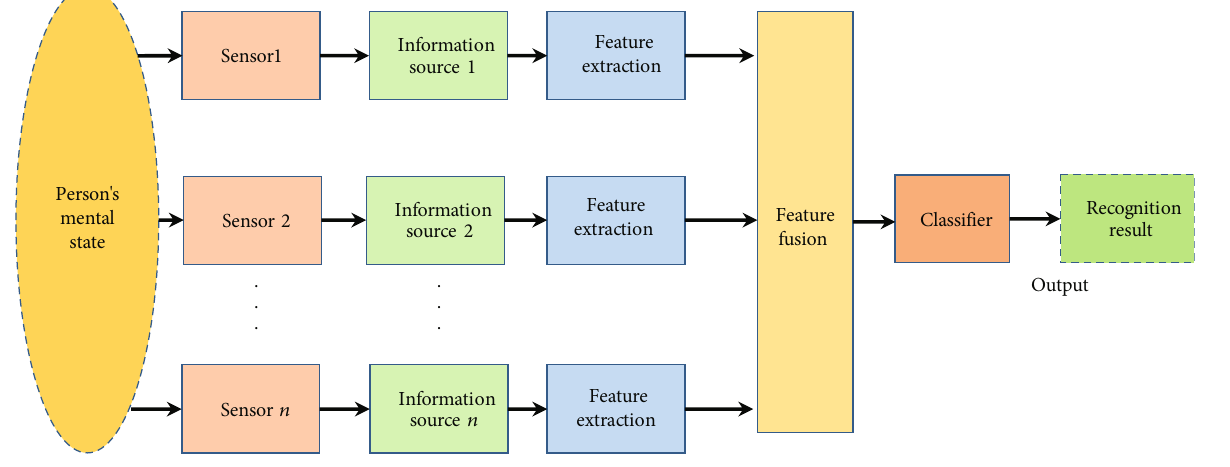
Figure 2: Feature layer fusion process